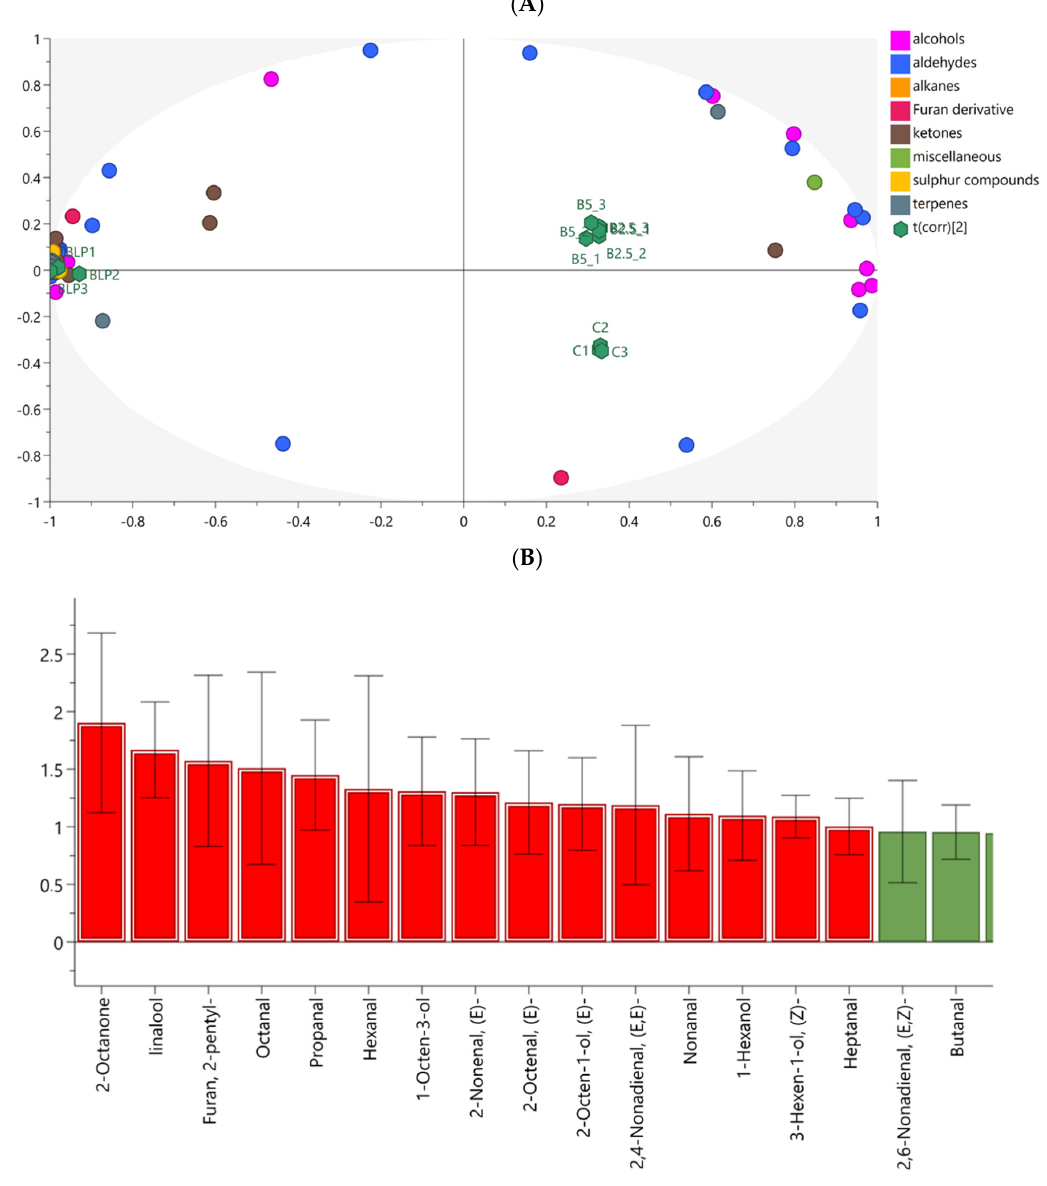
Figure 3. Orthogonal partial least-squares discriminant analysis (OPLS-DA) of experimental pasta and BLP ( R 2 X = 0.966; R 2 Y = 0.960; Q 2 = 0.810). ( A ) biplot presenting the association between VOCs and samples; ( B ) variable importance in projection (VIP) score. A VIP value >1.00 indicates the contribution of VOCs in separating the groups (blue bars).